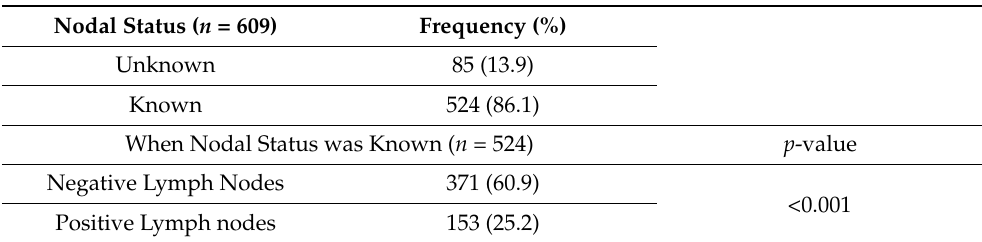
Table 5. Regional lymph node status of 609 patients with parathyroid cancer from the Surveillance, Epidemiology, and End Results (SEER) database,